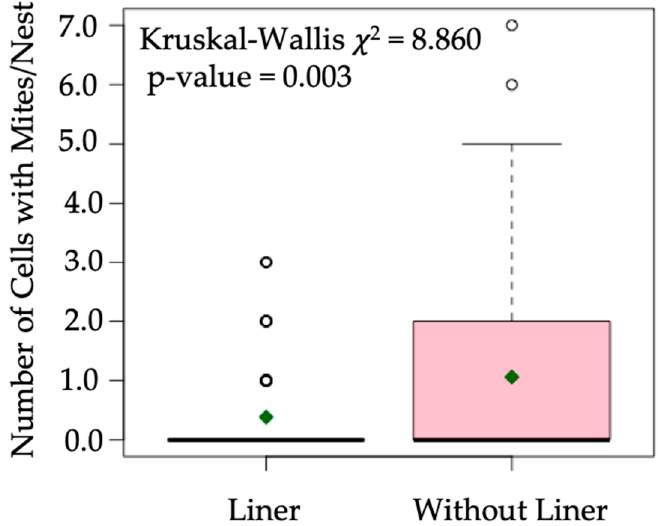
Figure 1. Mean number of mite infested Osmia cornifrons nest cells in manipulated nests (i.e., nests with paper liners) and its comparison with the nests without paper liners. The thick horizontal line in the plot represents median, the green diamond indicates mean, and the box indicates the 25th–75th percentile range. Whiskers represent the range of data, while the circles represent outliers. The Kruskal–Wallis rank sum test was performed for significance test ( p -value < 0.05).